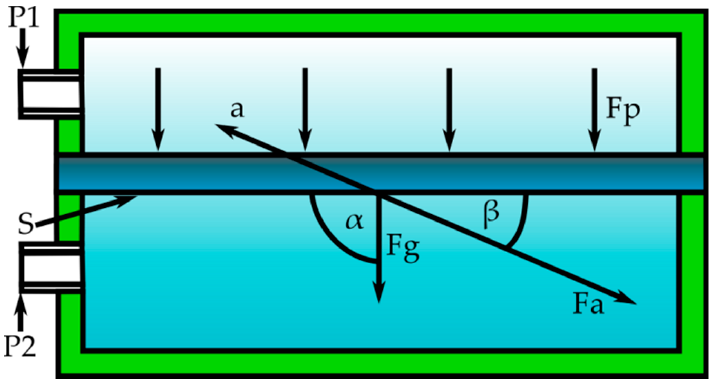
Figure 2. Model of a pressure transducer with an indication of the elastic diaphragm and force components where: Fp—pressure force; Fg—gravitational force; α —angle between the plane of the diaphragm and the vertical direction; Fa—force due to dynamic acceleration; and β —angle between the plane of the diaphragm and the direction of the transducer movement, a—acceleration of a moving sensor installed on a moving object, S-membrane surface, g-gravitational acceleration, and m-mass of the membrane and the separator .